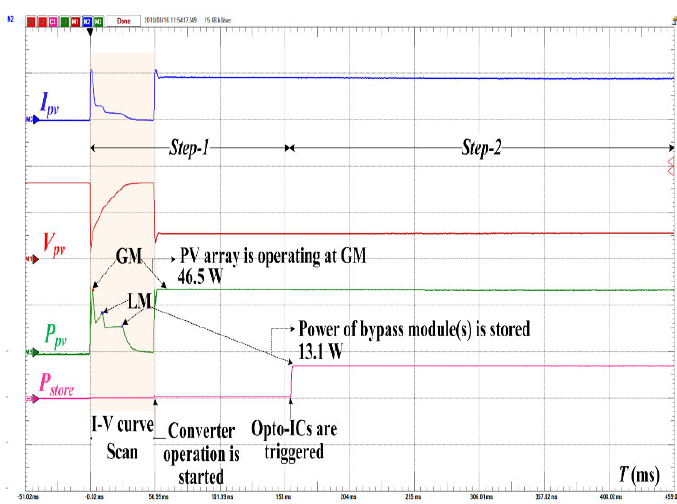
Figure 17 . Experimental result in case 3 . Figure 17. Experimental result in case